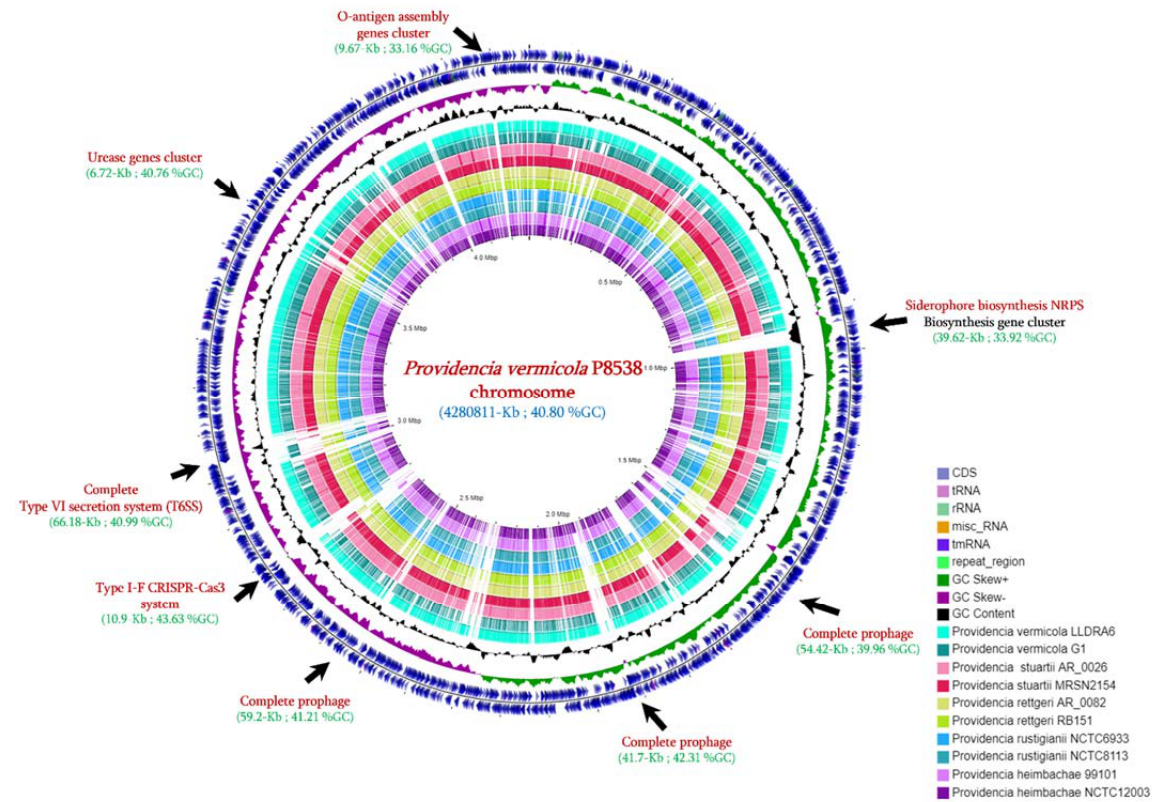
Figure 1. Circular map of the P. vermicola P8538 chromosome and its genomic comparison with the nine closest Providencia genomes.